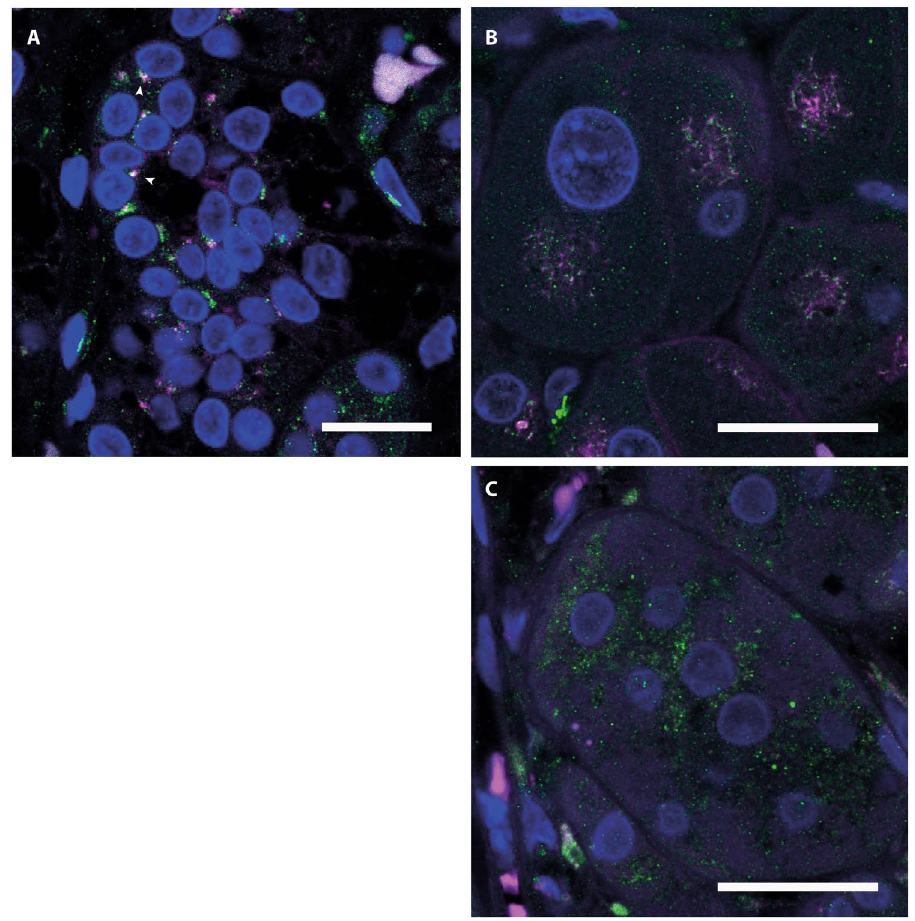
Figure 4. Co-immunofluorescence of RII β and the Golgi apparatus. Representative co-immunofluorescence of RII β (magenta) and the Golgi marker 58K protein (green) in a PRKACA WT tumour ( A , B ) and in an PRKACA L206R mut tumour ( C ). The overview shows accumulation of RII β in localized areas close to the nucleus and the overlay with the Golgi apparatus marker reveals co-localization (white, arrowheads). A higher magnification of the same tumour shows the close proximity of RII β and the Golgi apparatus ( B ), while the RII β staining is absent in the L206R mutated tumour ( C ). Scale bar 20 µ m ( A ) and 10 µ m ( B , C